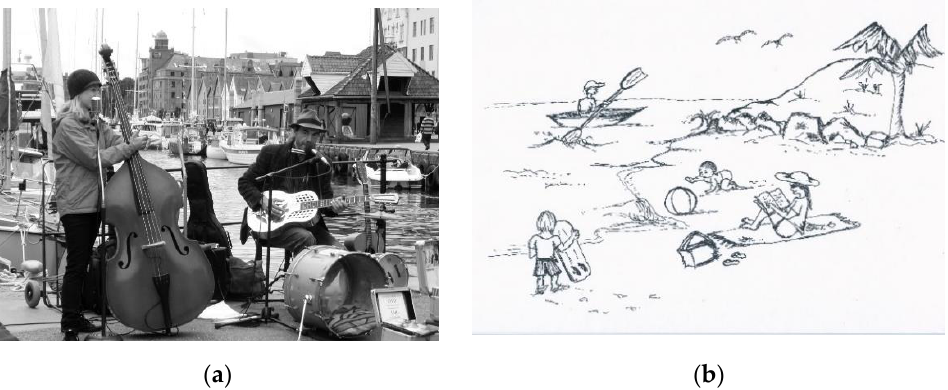
Figure 1. Complex scene description pictures for the BELS spontaneous speech subtest: ( a ) Buskers scene (initial BELS); and ( b ) Australian Beach Scene (final BELS).